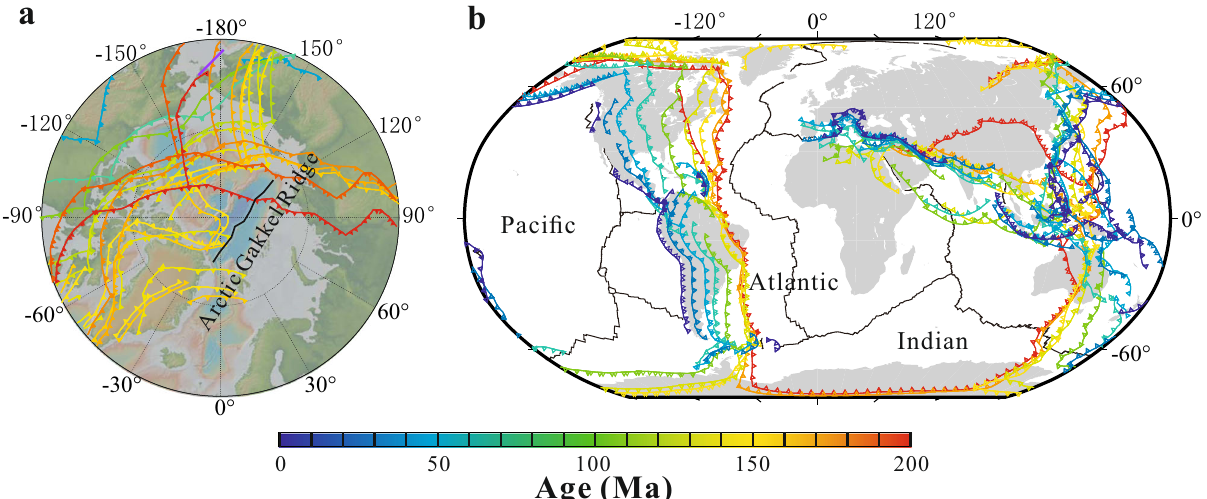
Fig. 3 Subdution zone locations during the past 200 Myr. Reconstructed subduction locations during the past 200 Myr for a Arctic Ocean, and b Indian and Atlantic Oceans, modi fi ed from Shephard et al. 21 and Young et al. 65 , respectively.